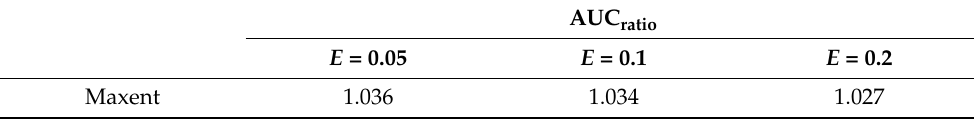
Table 1. AUC ratio values based on the estimation of different E values for